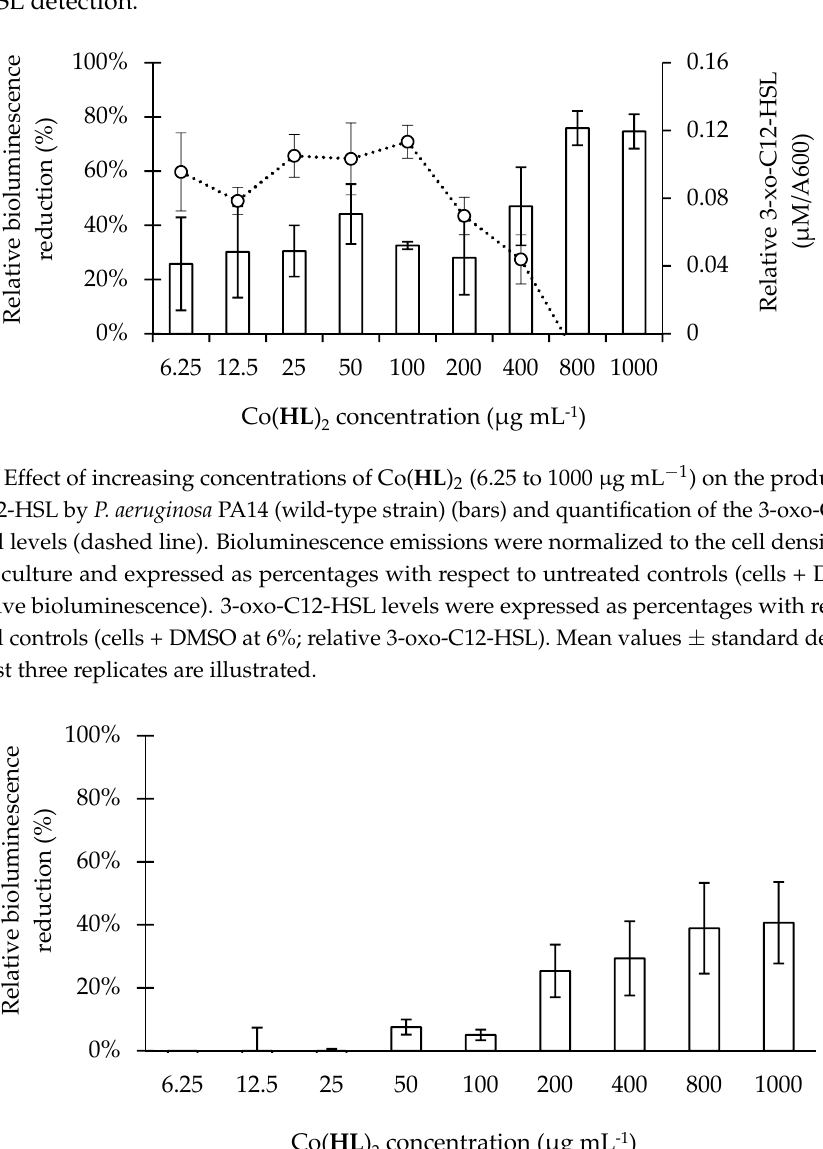
Figure 3. Effect of increasing concentrations of Co( HL ) 2 (6.25 to 1000 µg mL − 1 ) on the detection of 3-oxo-C12-HSL by P. aeruginosa PA14-R3 (biosensor strain). Bioluminescence emissions were normalized to the cell density of the bacterial culture and expressed as percentages with respect to untreated controls (cells + DMSO at 6%; relative bioluminescence). Mean values ± standard deviations for at least three replicates are illustrated.